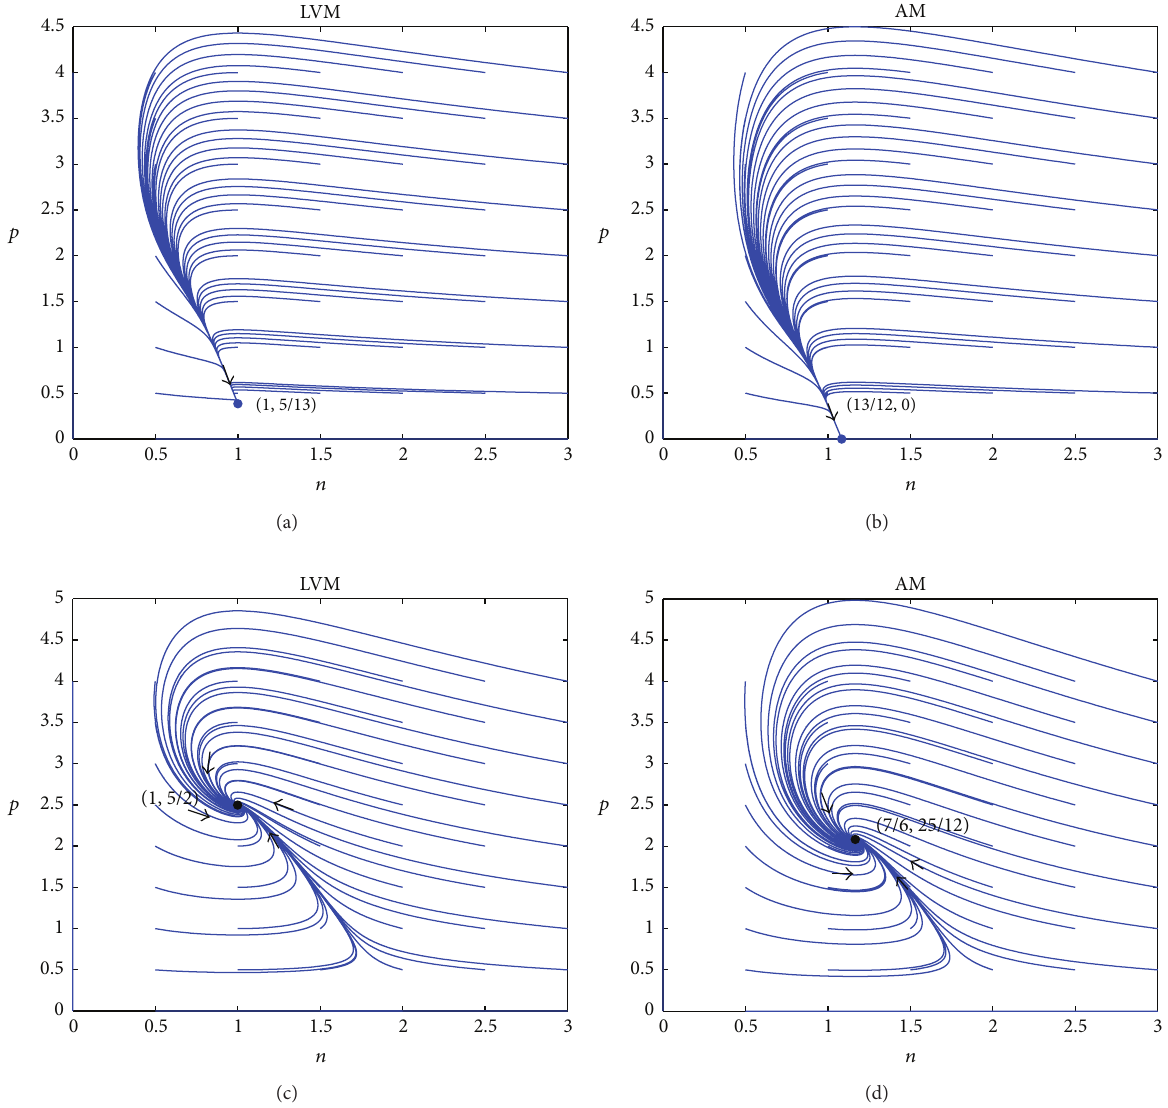
Figure 2: The dynamics of LVM and AM given the condition 𝐶 > 𝑢/𝛼 . Parameters are 𝑟 = 5 , 𝐾 = 13/12 , 𝑎 = 1 , 𝛼 = 1 , 𝐶 = 3/2 , and 𝑢 = 2 in the first two figures, all parameter values are the same in the other two except 𝐾 = 2